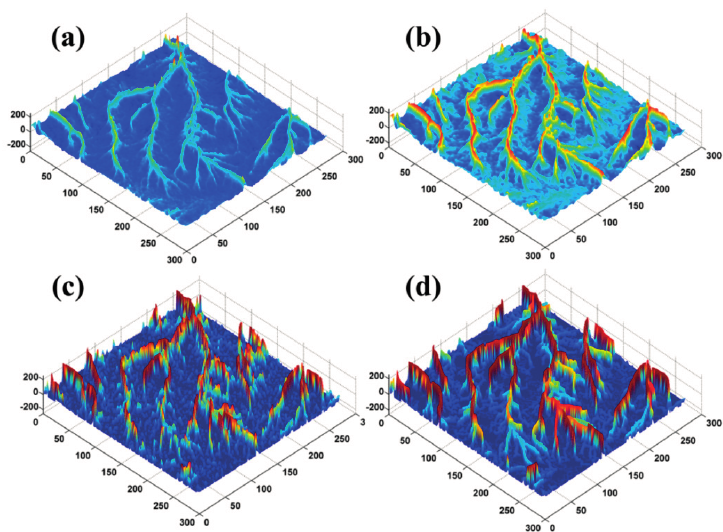
Figure 3. Three-dimensional view of the images in Figure 2: ( a ) the original image, ( b ) the pre-processed image, ( c ) the image after Gabor filtering, and ( d ) the image after path